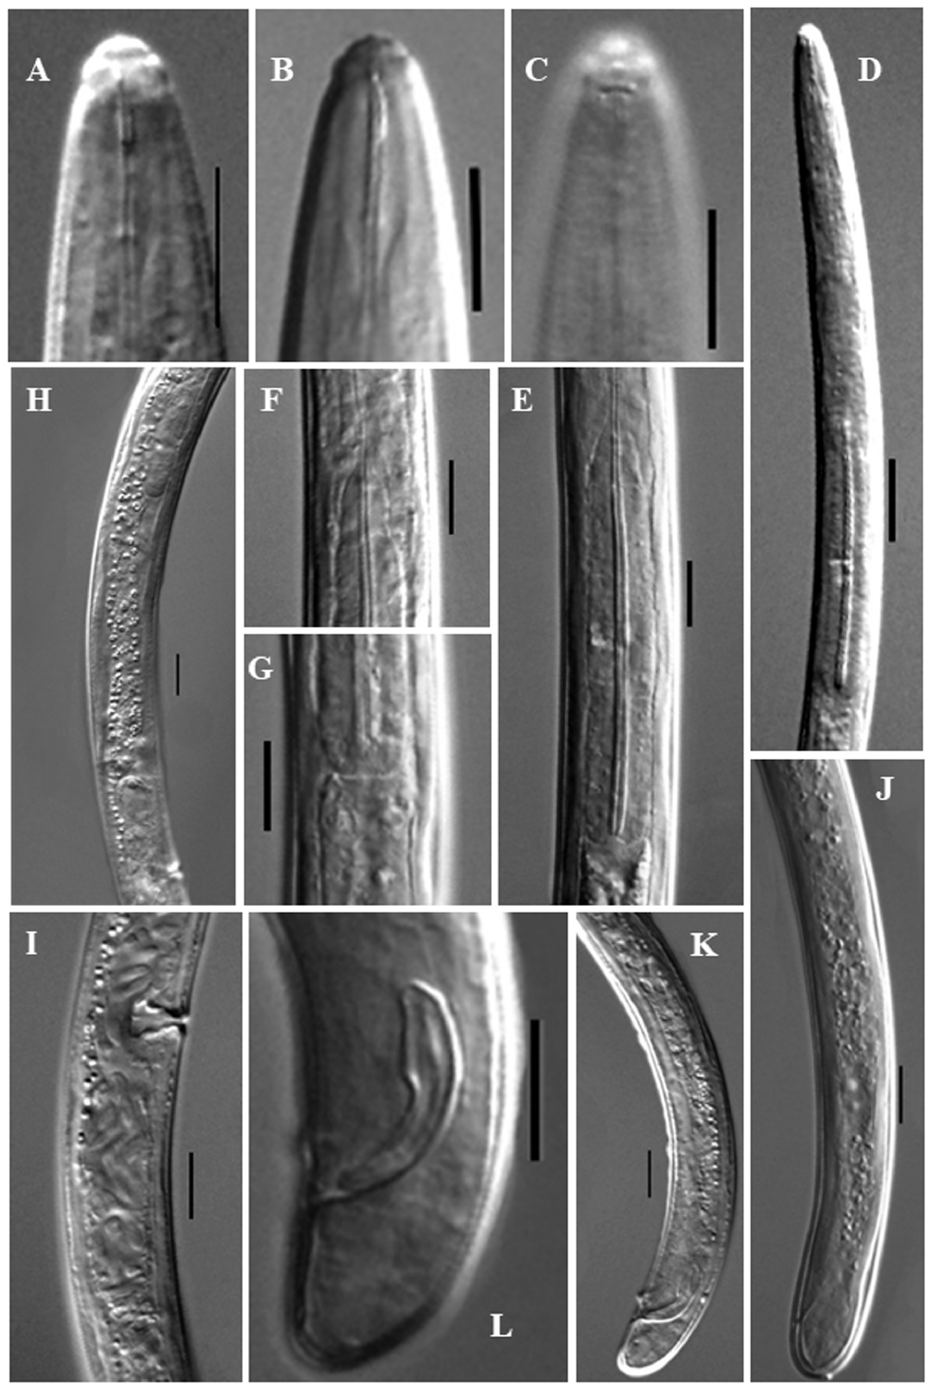
Fig. 12. Tylencholaimus southindicus sp. nov. (LM photographs). A . Paratype 1, ♀ (slide 2). B, E, G . Holotype, ♀ (AMU/ZD/NC/ Tylencholaimus southindicus /1) . C–D, F . Paratype 5, ♀ (slide 3). H–J . Paratype 4, ♀ (slide 2). K–L . Paratype 3, ♂ (slide 2). A–B . Female anterior region. C . Female anterior region showing amphid. D . Female pharyngeal region. E . Female expanded part of pharynx. F . Female pharyngeal expansion. G . Female pharyngo-intestinal junction. H–I . Female genital system. J . Female posterior region. K . Male posterior region. L . Male posterior end showing spicules. Scale bars: A–C, E–L = 10 μm; D = 20